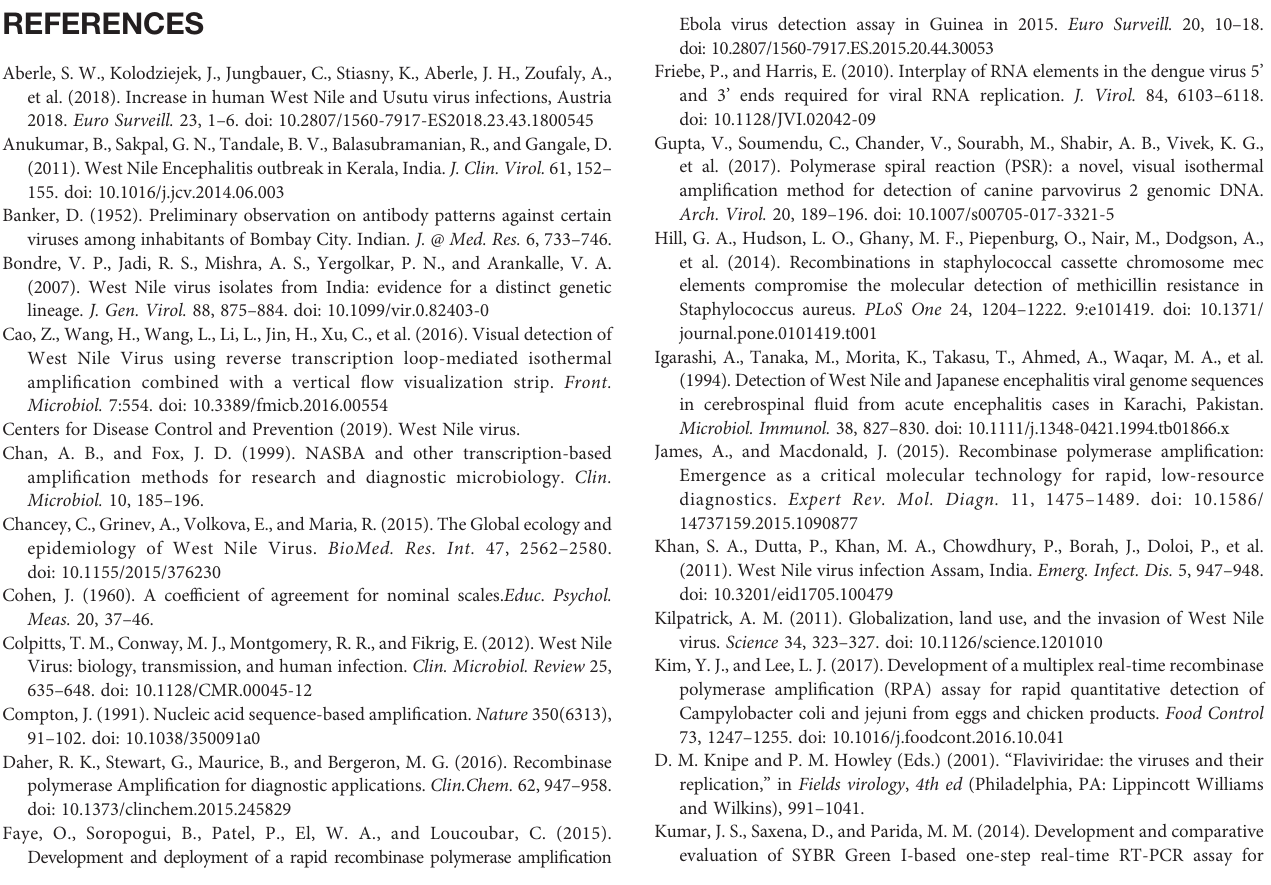
Supplementary Figure 1 | Details of the RPA amplicon for WNV. The nucleotide alignment matching in different strains of WNV. Primers and probe sequences are bold, highlighted and underlined. WNV RPA forward primer and probe is presented in sense, and the reverse primer is presented as reverse complement